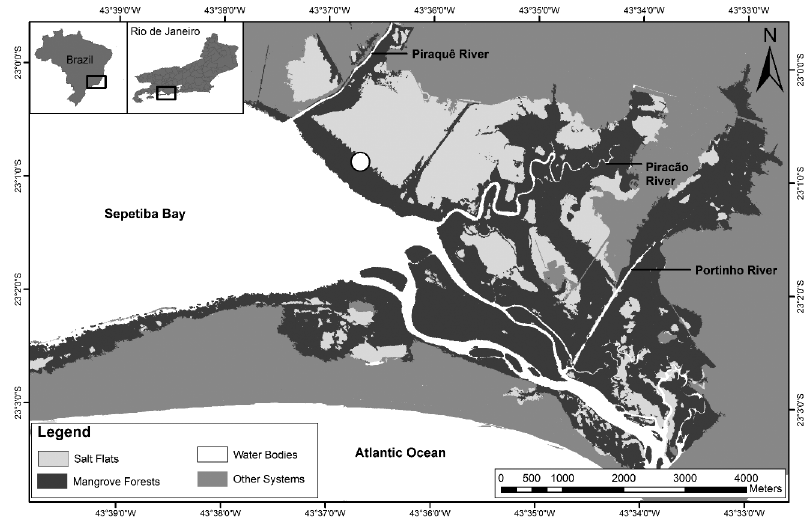
Figure 1 - Map of the study area. The sampling point is indicated with a white